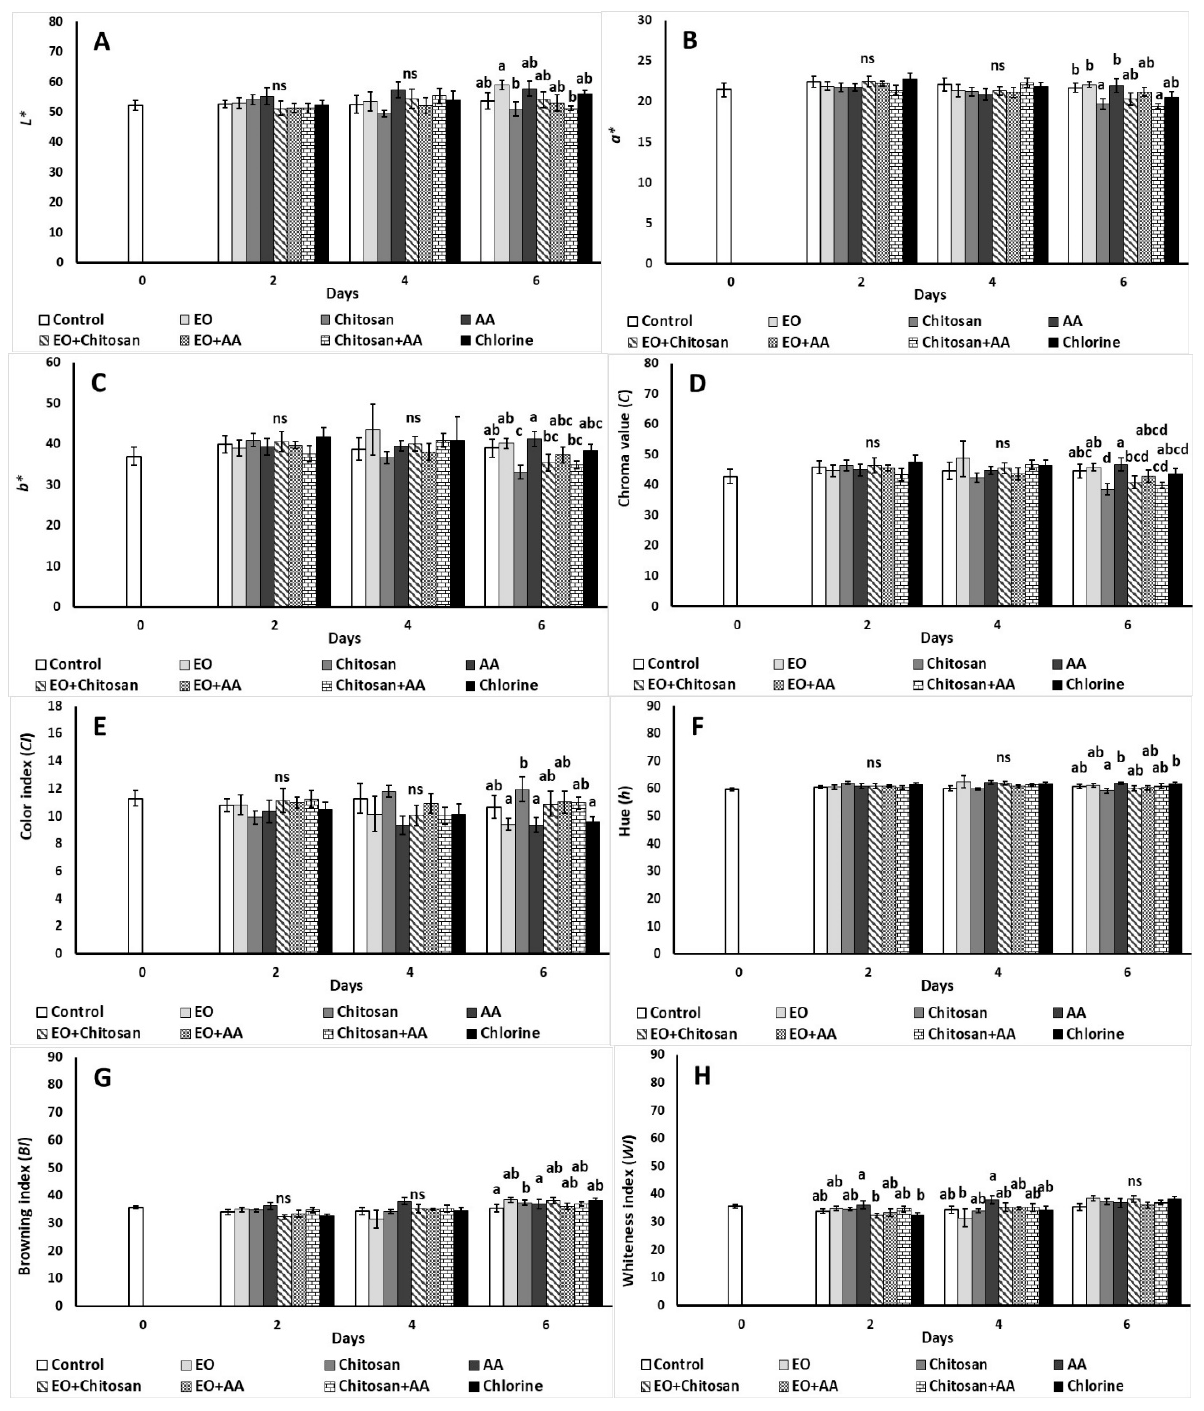
Figure 3. Effect of marjoram essential oil (EO), chitosan, and ascorbic acid (AA) on fresh-cut lettuce on ( A ) L* value, ( B ) a* (greenness) (positive values), ( C ) b* (yellowness), ( D ) chroma, ( E ) color index (positive values), ( F ) hue (positive values), ( G ) browning index, and ( H ) whiteness index after treatment and 6 days of storage at 7 °C and 90% RH. On the columns, significant differences ( p < 0.05) among treatments are indicated by different Latin letters; ns indicates no significant differences for different days. Values represent means (±SE) of measurements made on three biological replicates per treatment.